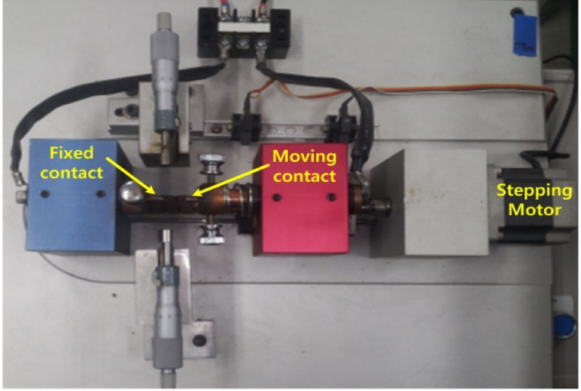
Figure 3. Experimental device for DC breaking arc.